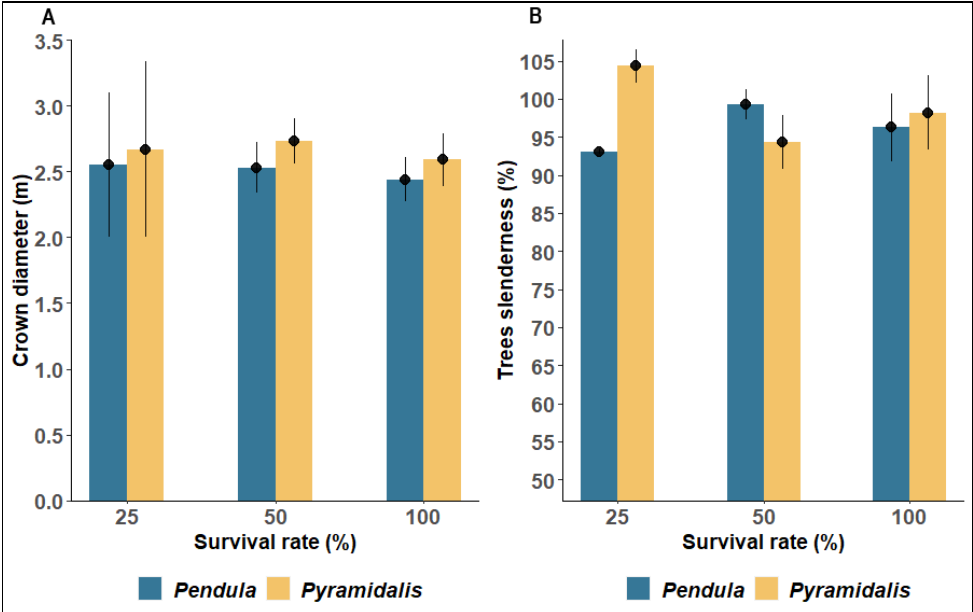
Figure 5. Variation in stability traits: crown diameter ( A ) and tree slenderness ( B ) by survival rate. The black vertical lines represent the standard deviation.